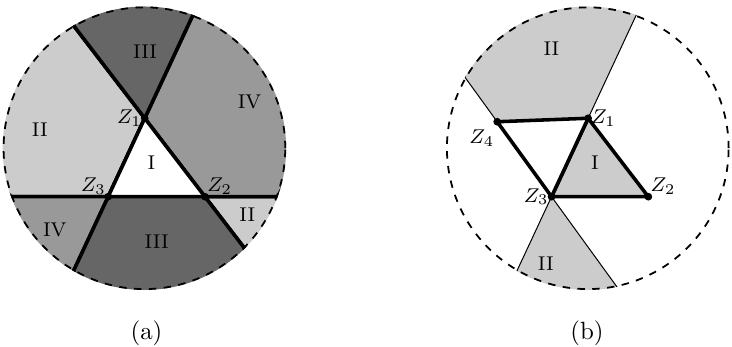
Figure 1 . Figures illustrating polygons in P 2 represented as a disc where opposite points of the disc are identi(cid:12)ed. In (cid:12)gure (a) we illustrate the fact that there are four triangles I ; II ; III ; IV all of which have the same three vertices Z 1 ; Z 2 ; Z 3 and all having the same canonical form